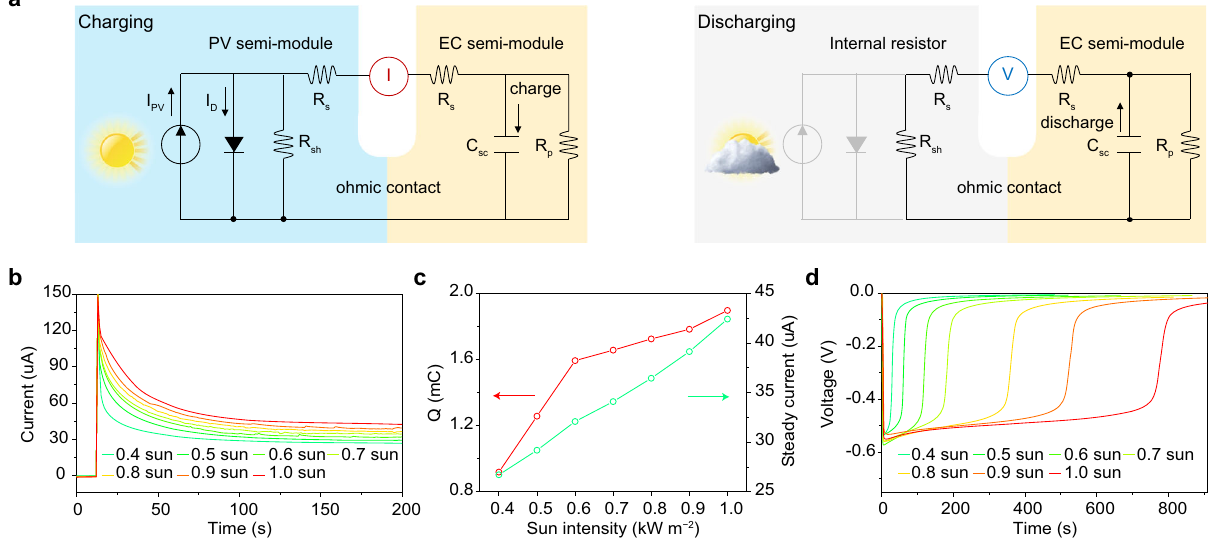
Fig. 4 Working principles of solar-adaptable PVCD. a Charging state and discharging state circuit diagrams of solar-adaptable PVCD. b Real-time current ( I − t ) tendencies in external circuit of PVCD during charging process under different sunlight intensities. c The capacitance ( Q ) of EC components after the charging process is completed for PVCD charged by different sunlight intensities. d Real-time voltage ( V − t ) tendencies in external circuit during discharging process for PVCD charged by different sunlight